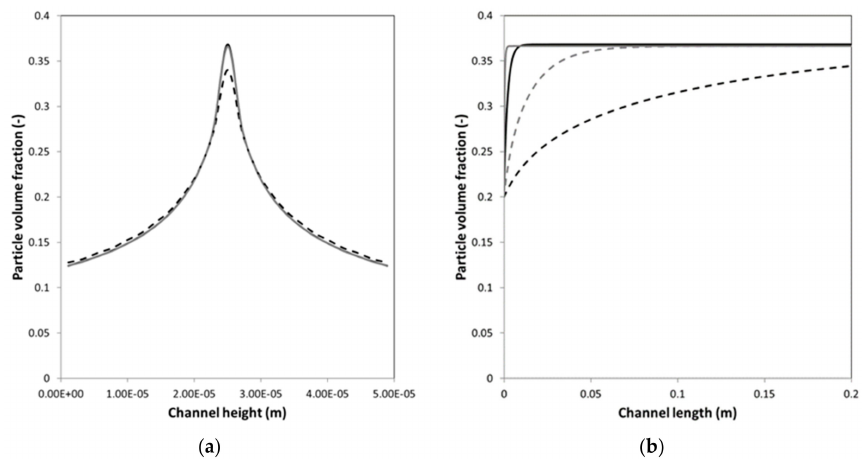
Figure 5. ( a ) Particle volume fraction versus the channel height and ( b ) the particle volume fraction in the center of the channel versus the channel length for different friction factors for both the drag and Shear induced diffusion (SID) force: f both SID and drag (grey solid line); f D (cid:0) (cid:1) f α p for drag (grey dashed